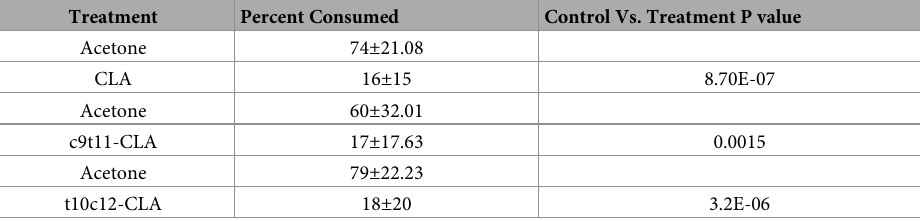
Table 4. Larval L . decemlineata choice assay of CLA